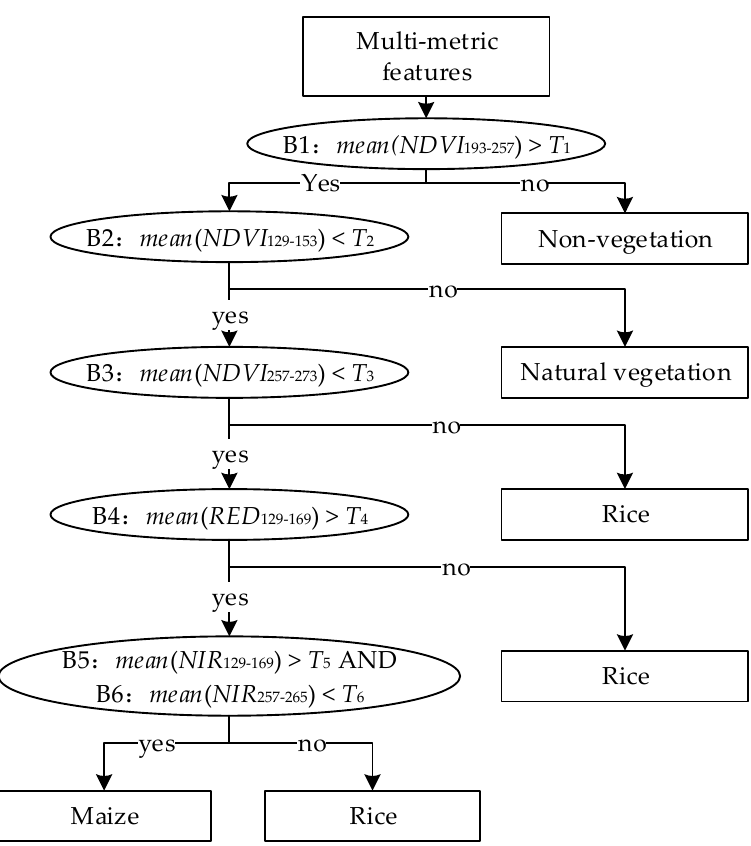
Figure 7. The decision tree for maize identification.